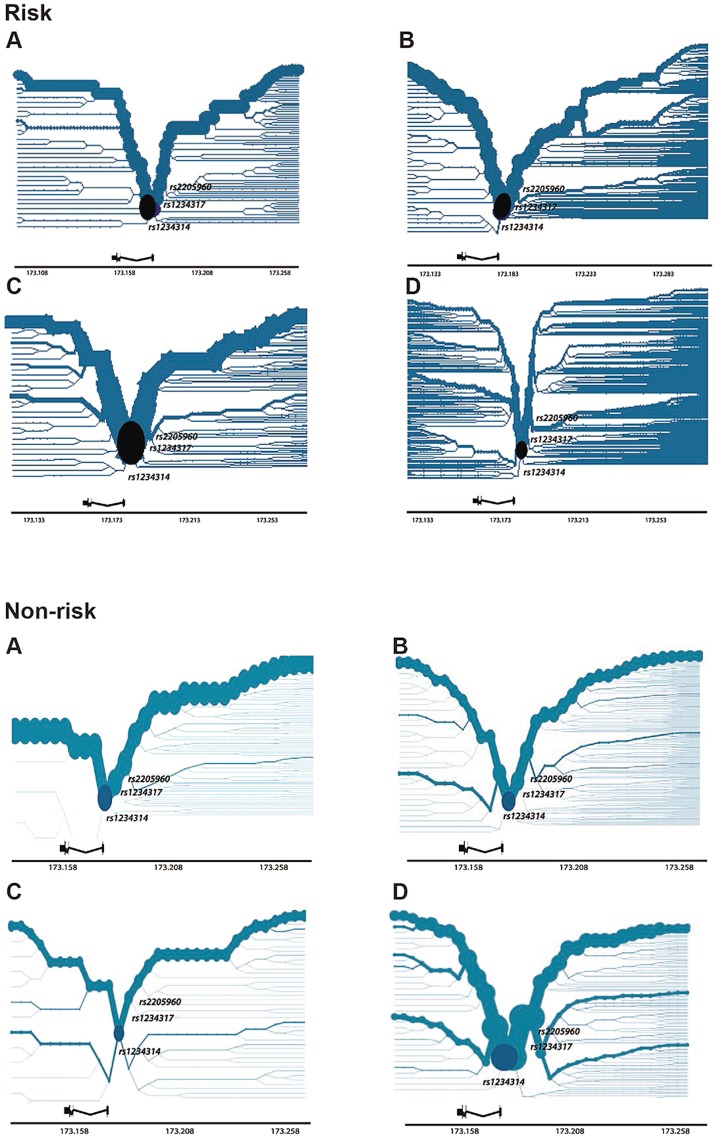
Haplotype Bifurcation Diagrams of TNFSF4risk and TNFSF4non-
risk for Four Populations.Plots are constructed using phased haplotypes for a. East Asians, b. Europeans, c. Hispanics and d. African-Americans and illustrate breakdown of LD with increasing distances from a core proximal TNFSF4 SNP and are approximately to scale. The core is located at the TNFSF4 gene-5′ boundary (black circle) and is selected as the most proximal 5′ marker, rs1234314, in each population. Gene location is depicted to scale; we have additionally labelled each plot to show the location of rs1234317 and rs2205960, the best-associated markers from the meta-analysis.